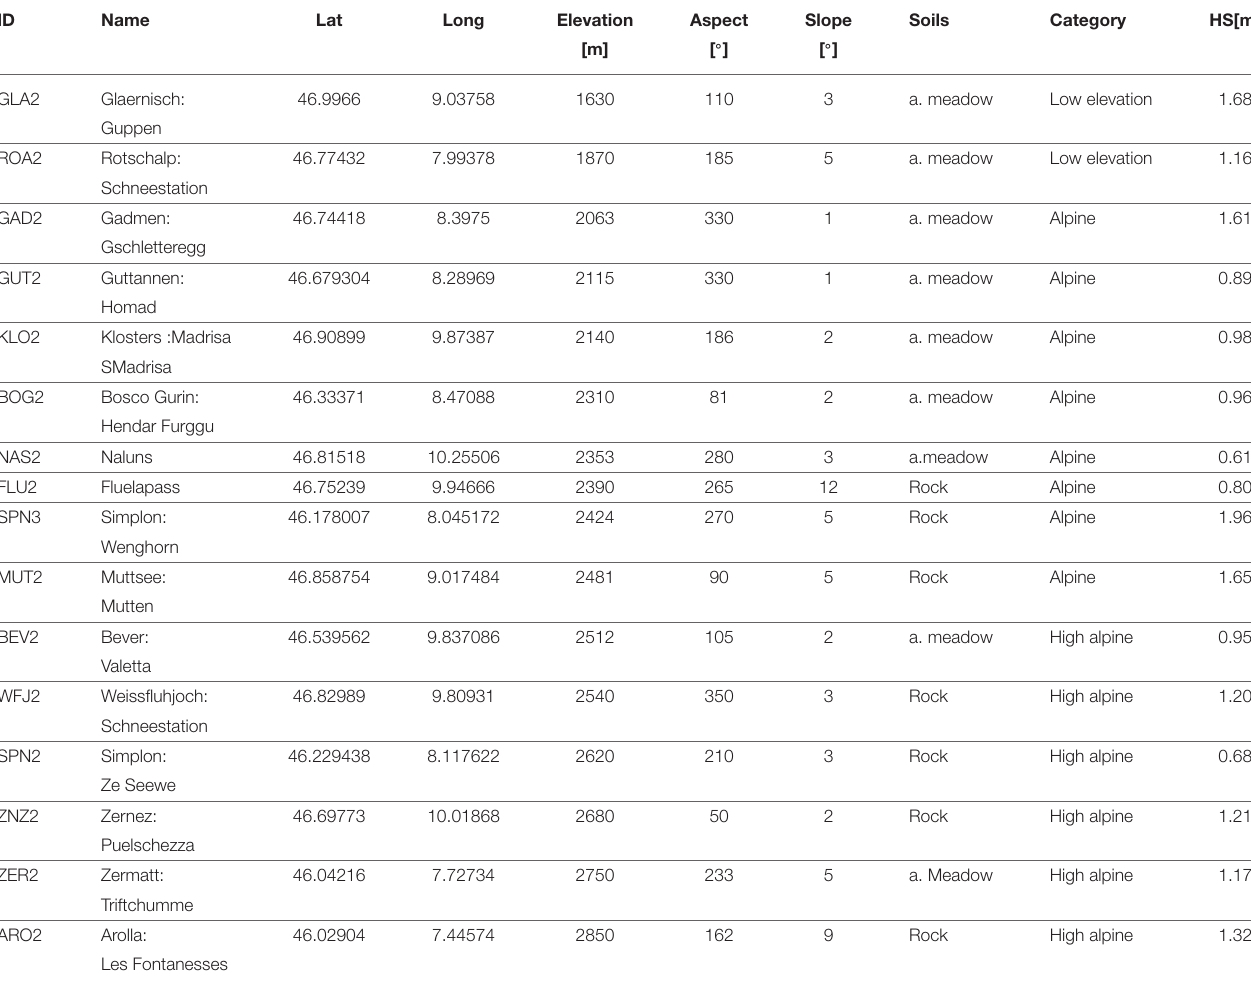
TABLE 1 | ID, name, location, elevation, slope aspect, slope angle (Slope), soil type, category (a. meadow stands for Alpine meadow) and mean snow height, for all days were snow height (HS) > 0.1 m for all stations used in the